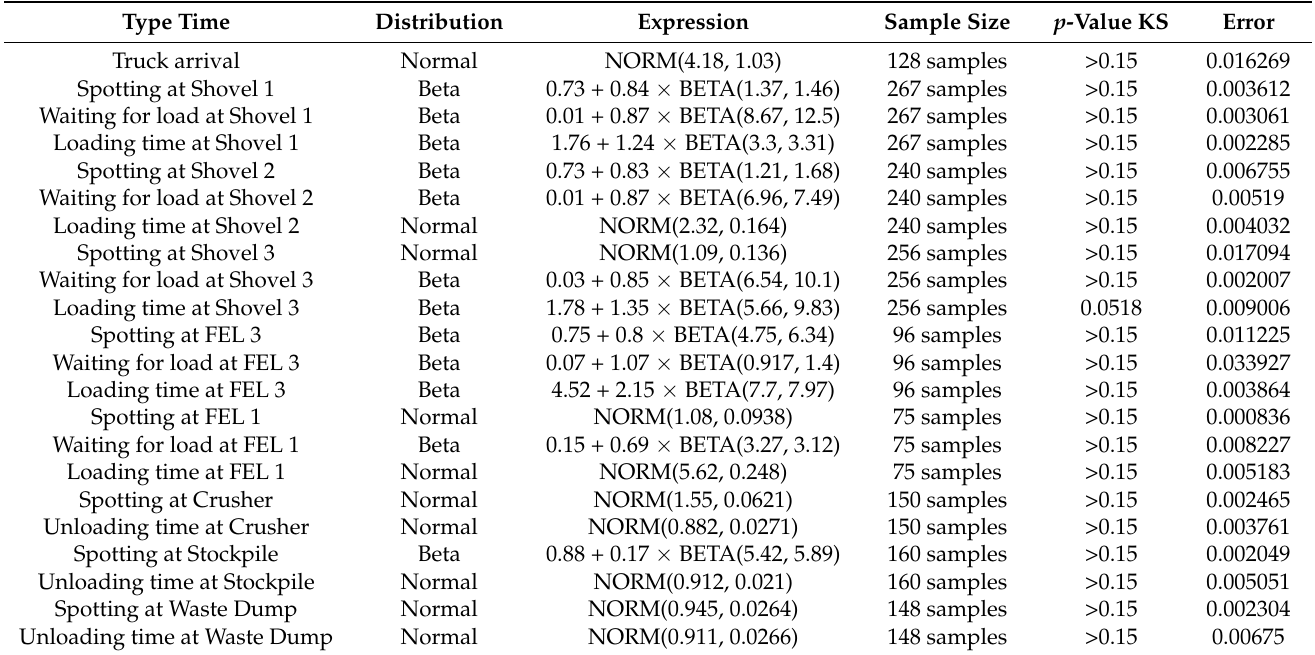
Table 3. PDF of the fixed times for